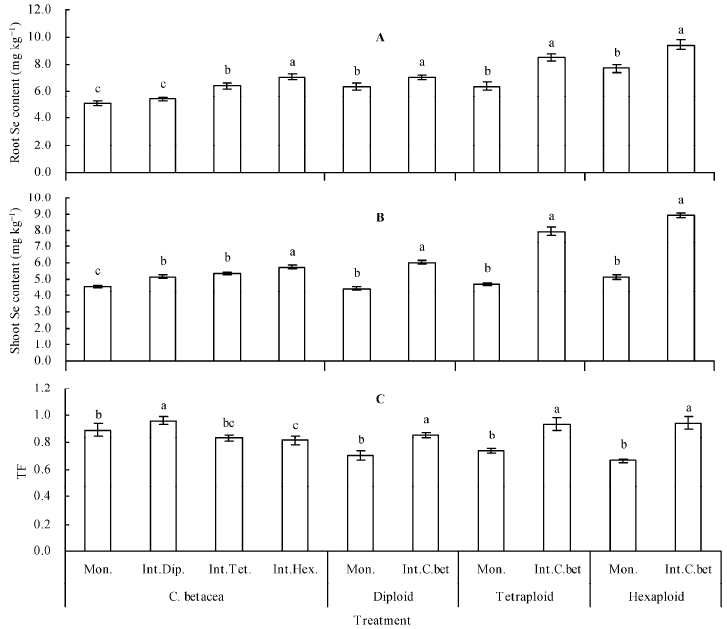
Figure 3. Se content and TF of plants. ( A ) Root Se content; ( B ) shoot Se content; ( C ) TF (translocation factor). Values are means ± SD of three replicates. Different lowercase letters indicate significant differences among the treatments (Duncan’s multiple range test, p < 0.05). Mon. = monoculture; Int.Dip. = intercropped with diploid; Int.Tet. = intercropped with tetraploid; Int.Hex. = intercropped with hexaploid; Int.C.bet = intercropped with C. betacea .